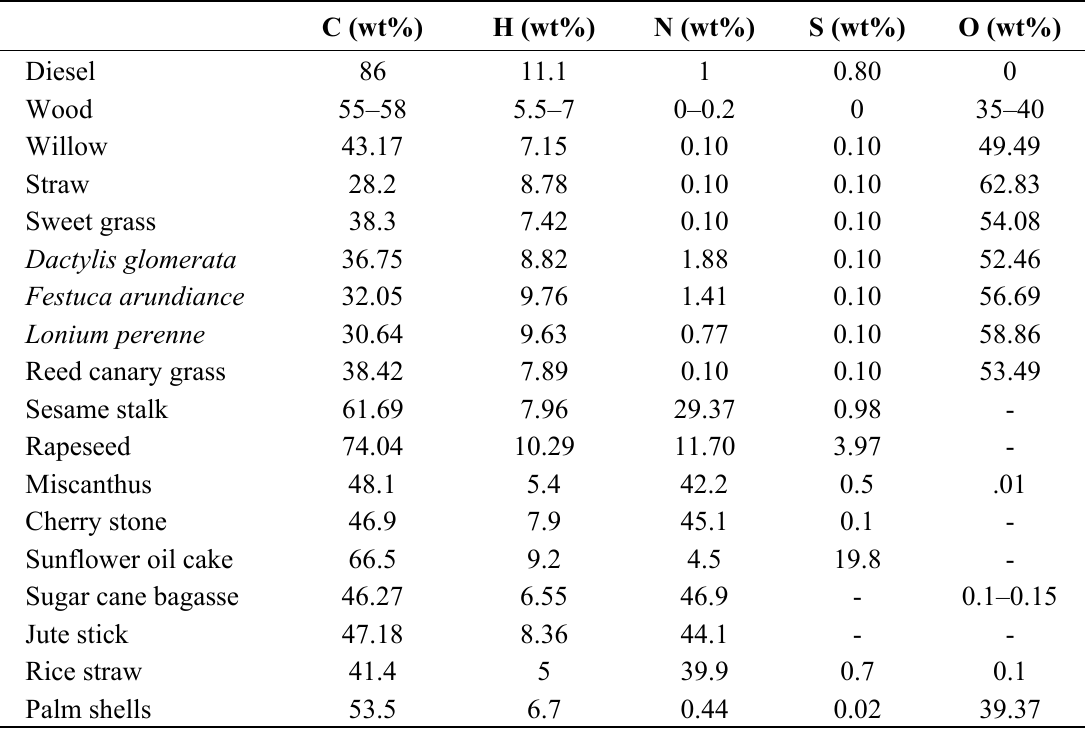
Table 9. Elementary analysis of No 2 Diesel, coal and pyrolysis bio-oil from different feed stocks